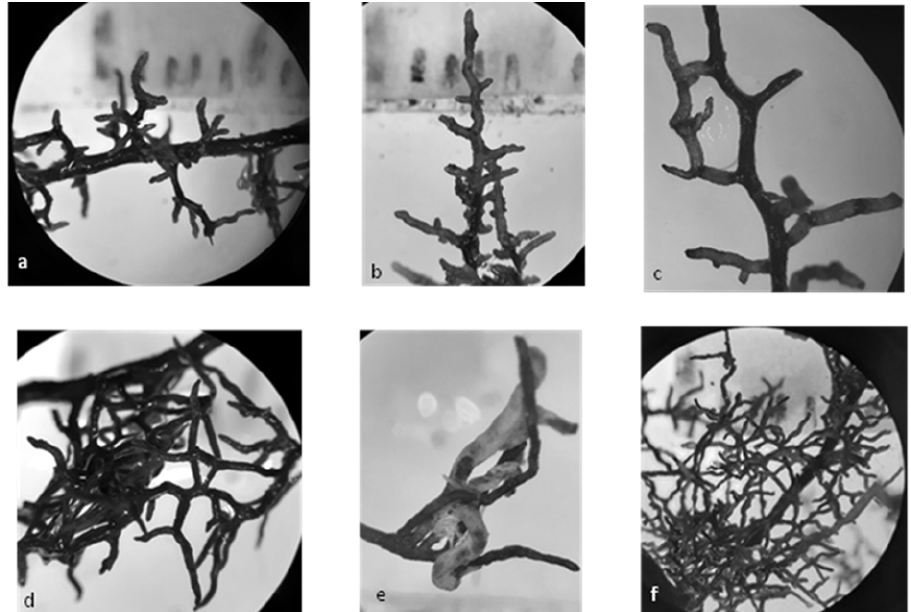
Figure 5. ECM branching types of C. illinoinensis (Wangeh) K. Koch in Chihuahua, Mexico. ( a ) Juvenile stage of dichotomous ramifications; ( b ) pyramidal monopodial; ( c ) simple; ( d , f ) coralloid; ( e ) simple, covered with a fungal mantle.